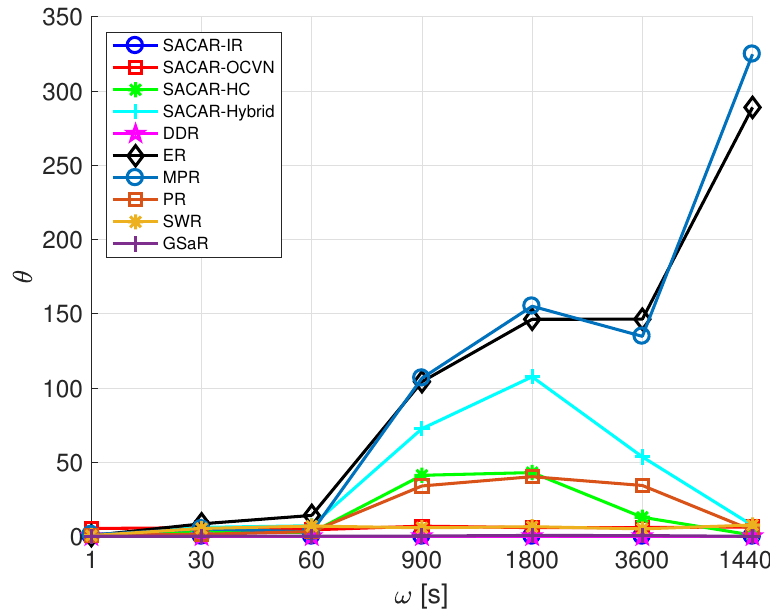
Figure 9. Overhead ratio ( θ ) vs. frequency of message generation ( ω ): smart office